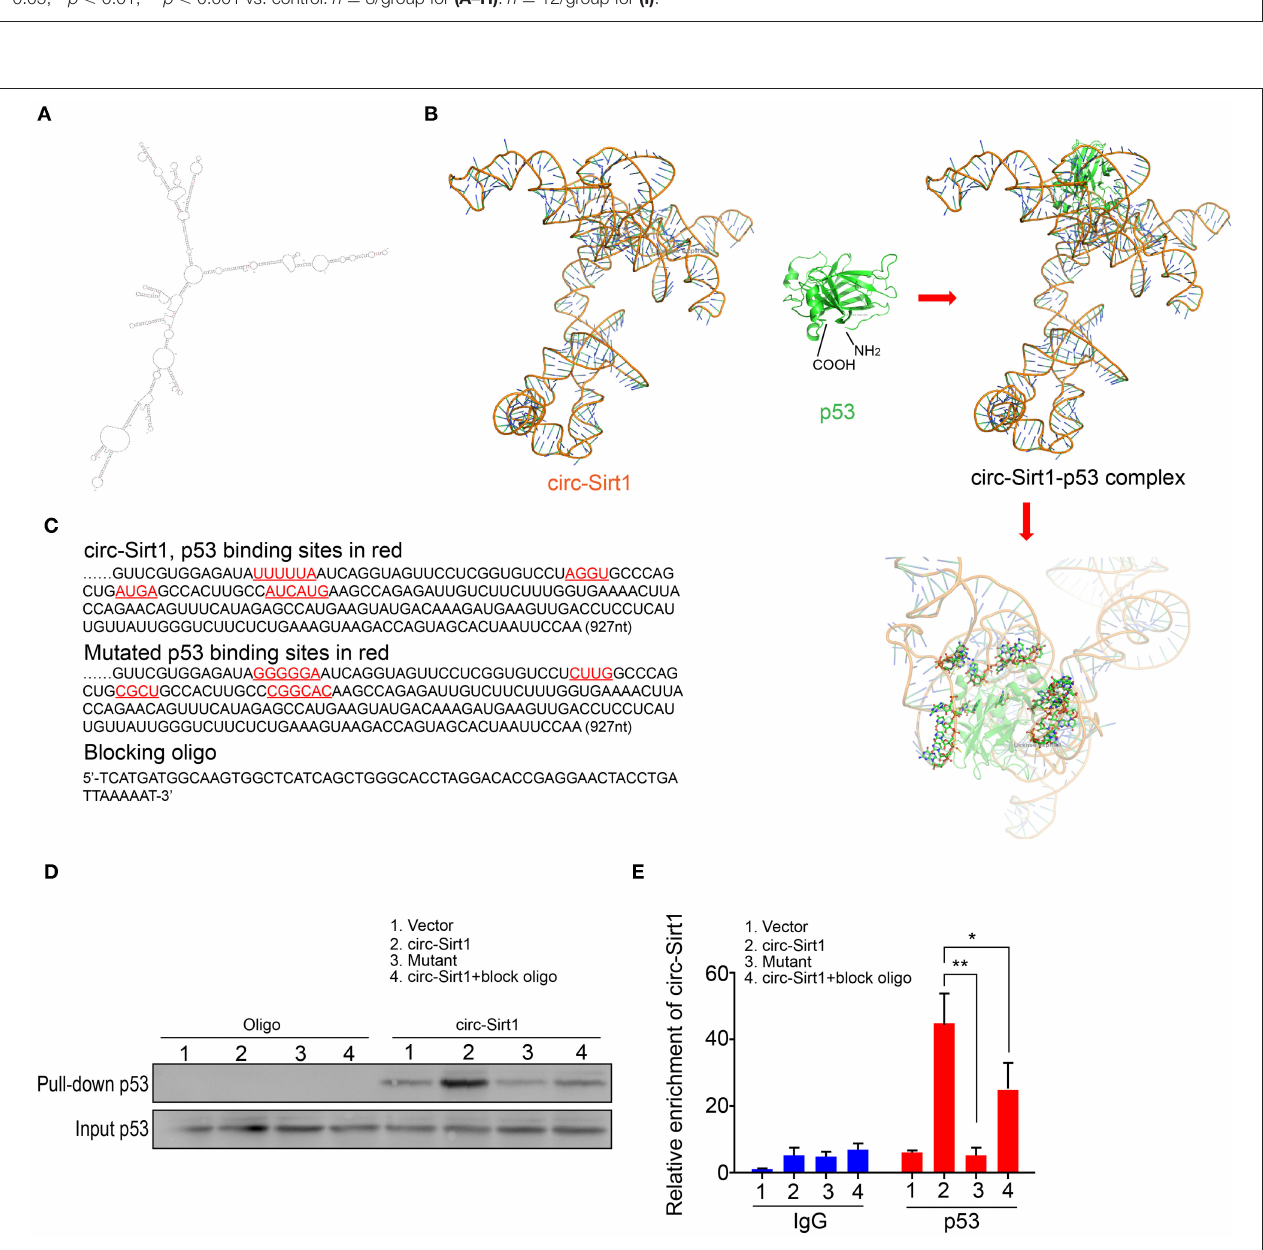
FIGURE 3 | with Ad-circ-Sirt1. Bar graphs represent the mean ± SD and were analyzed with Student’s T -tests. ** p < 0.01 vs. Ad-Vector + Ang II untreated group. # p < 0.05 vs. Ad-Vector + Ang II group. (E) ChIP assay for p53 bound to p53 DNA elements in VSMCs treated with Ang II. (F) qRT-PCRs for circ-Sirt1 expression in the nuclear and cytoplasm fractions of VSMCs. (G) RNA in situ hybridization for the localization of circ-Sirt1 in VSMCs. Scale bars = 25 µ m. (H) Representative immunofluorescence showing the localization of p53 in Ang II-treated VSMCs at 3, 4, and 5 days. Scale bars = 25 µ m. (I) Overexpressing circ-Sirt1 decreased nuclear translocation of p53 in VSMCs treated with Ang II. Scale bars = 25 µ m. Bar graphs represent the mean ± SD and were analyzed with Student’s T -tests. * p < 0.05, ** p < 0.01, *** p < 0.001 vs. control. n = 3/group for (A–H) . n = 12/group for (I) .